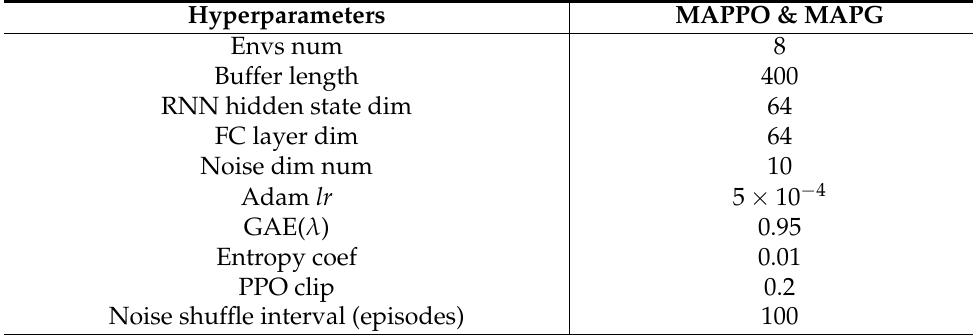
Table 2. Common hyperparameters used in MAPPO and its variants (NA-MAPPO and NV-MAPPO).